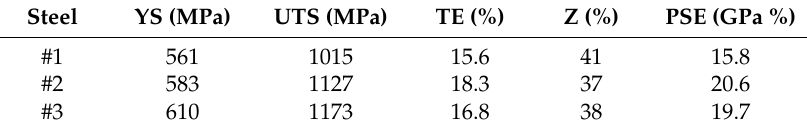
Table 3. Mechanical properties of samples with different compositions.